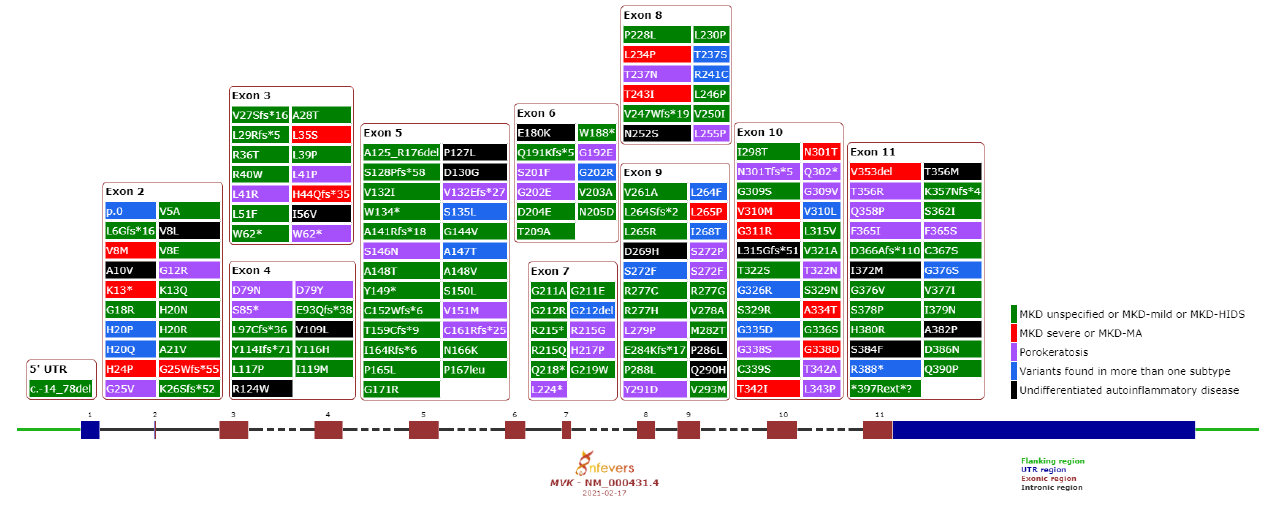
Figure 2. Sequence variants in the MVK gene (NM_000431.2). This schema has been generated from the “build your graph” module of Infevers (https://infevers.umai-montpellier.fr/web/graph.php?n=3&wid=1280&hei=720), (last search 12 March 2020). Benign and likely benign variants are not